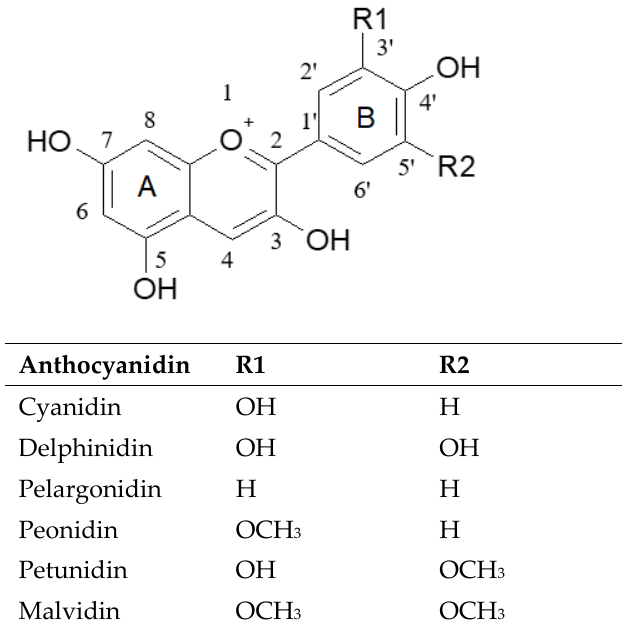
Figure 1. Chemical structure of the most common anthocyanidins.